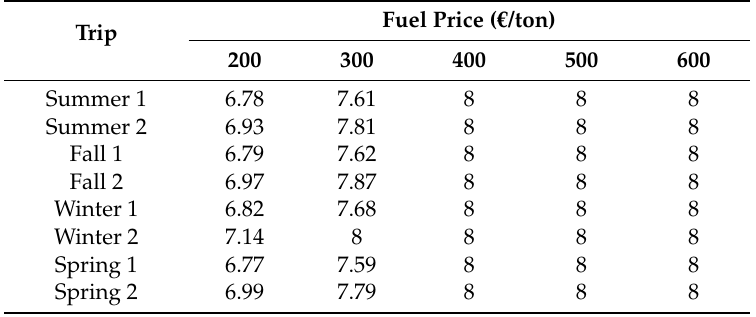
Table 40. Effect of fuel price on the optimal trip durations for nominal freight rate (numbers in days).